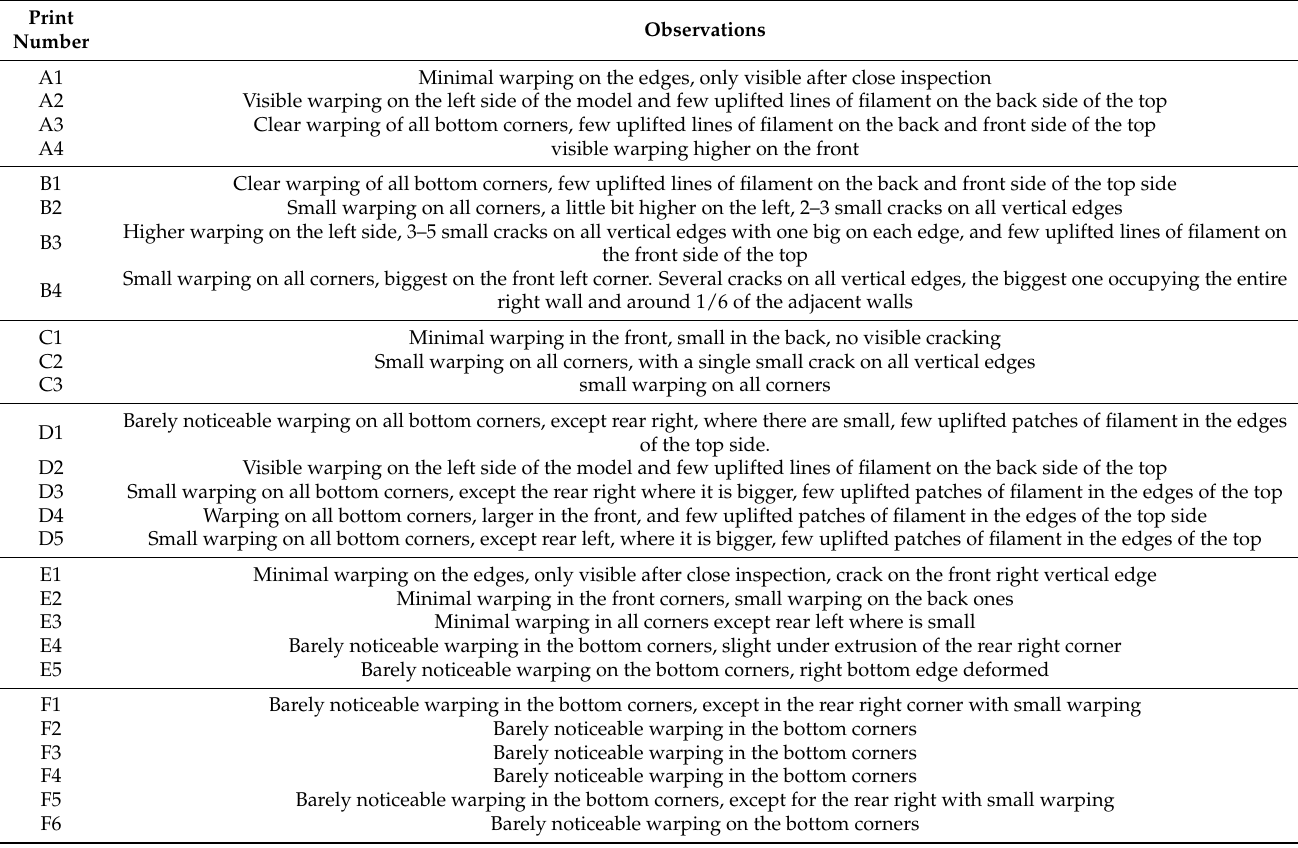
Figure 9. Photos of printed cubes for group E-F, placed on a 1 × 1 cm 2 grid. Table 3. Observations of the deformations of the printout by eye